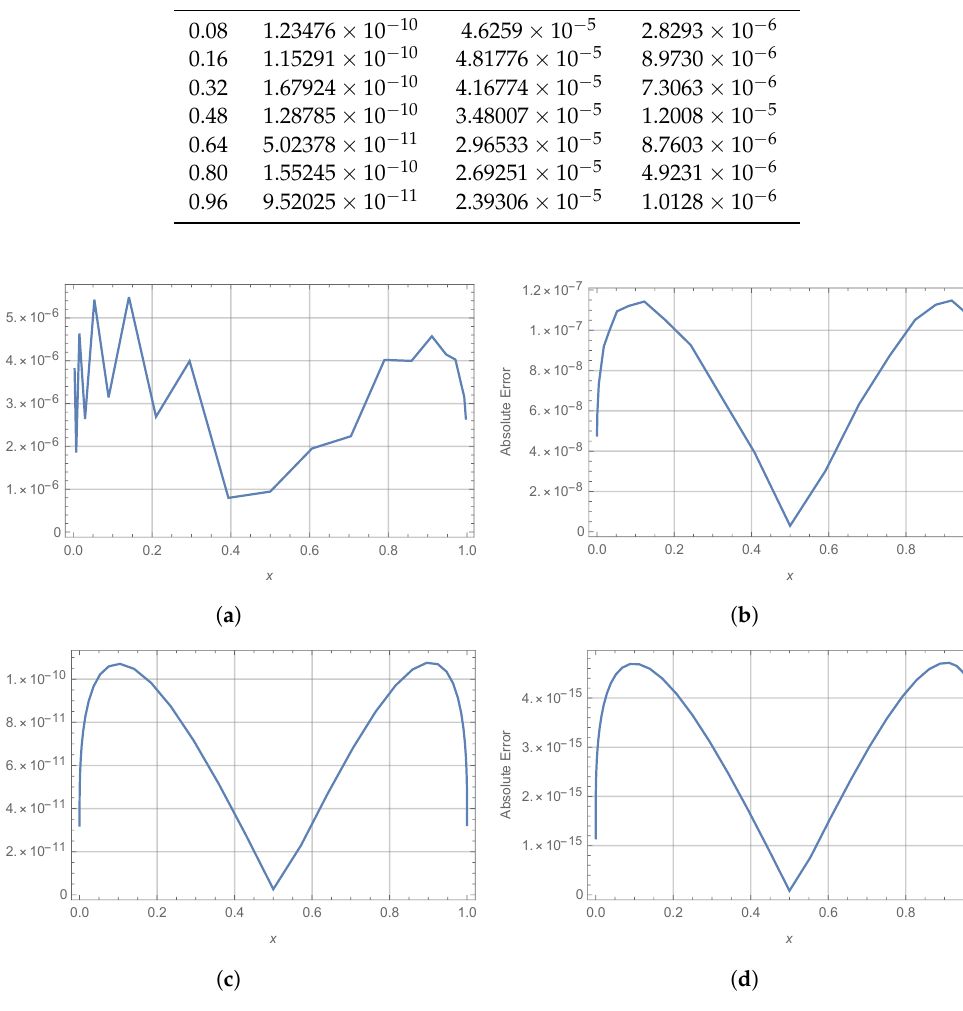
Figure 1. Plots of the absolute error of y ( x ) for Example 1 using the sinc-derivative interpolation for various values of N . ( a ) N = 10; ( b ) N = 15; ( c ) N = 25; ( d ) N =